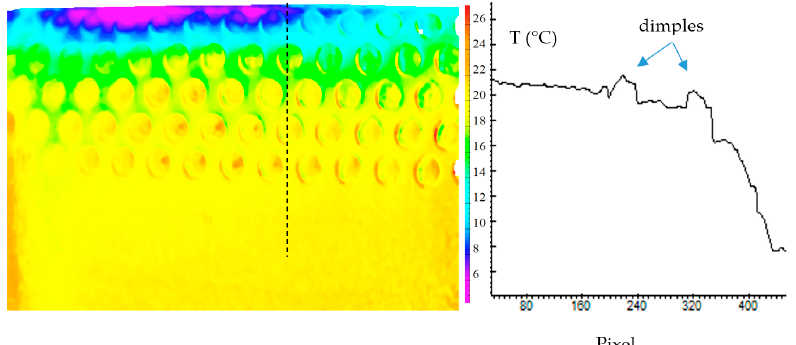
Figure 15. Average TSP map and line profile for the dimpled airfoil at the 15-degree AoA. Reproduced from Stolt et al. [30].